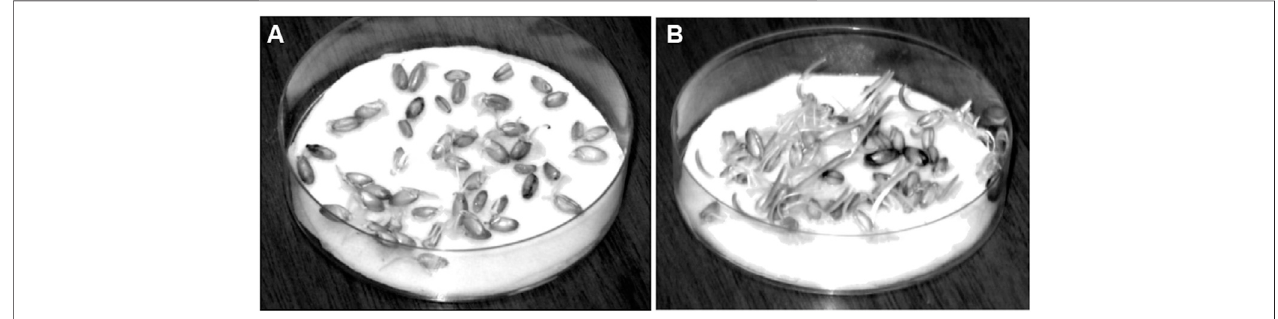
FIGURE2| Springspelledseedling,grade “ Gremme ” ,threedaysafterthebeginningofseedgerminationonasoakedpapertowelinaPetridishatatemperatureof +20 ° C (A) Paper towel soaked with a control 2 × 10 – 5 M KH 2 PO 4 solution; (B) Paper towel soaked with a Plasmolite-based 2 × 10 – 5 M KH 2 PO 4 solution.